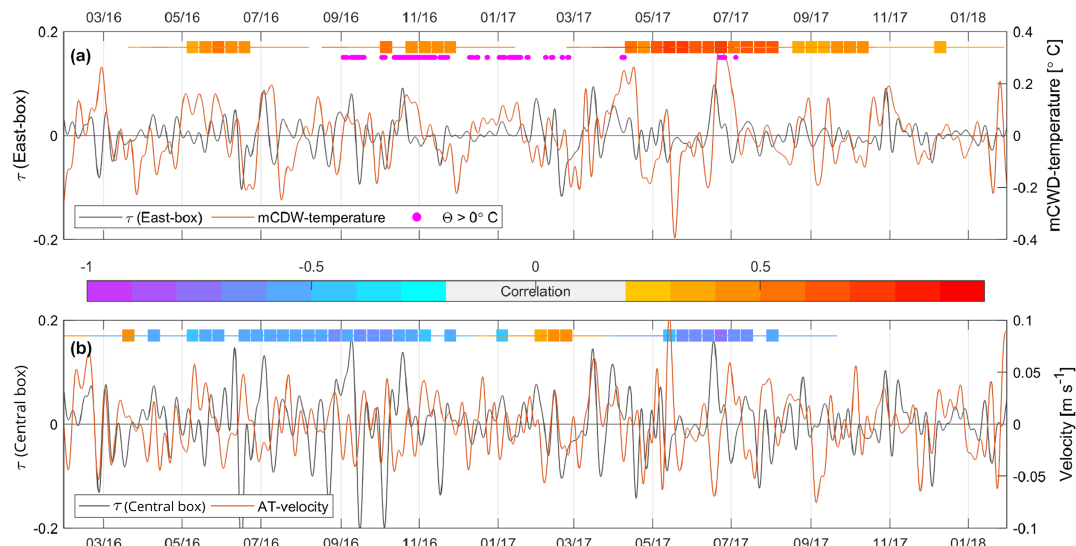
Figure 6. (a) τ D18 (black line) averaged over the East box and mCDW temperature at the mooring site (red line). The correlation between the time series is indicated by boxes and lines: Each colored box is the center of a 100d window (lines) with significant correlation of magnitude given by the color bar. The magenta dots show when temperatures above 0 ◦ C are present. Panel (b) is analogous to (a) , but for τ averaged over the Central box and along-trough (AT) velocity instead of temperature. All time series are filtered with BP 8D–10M ).